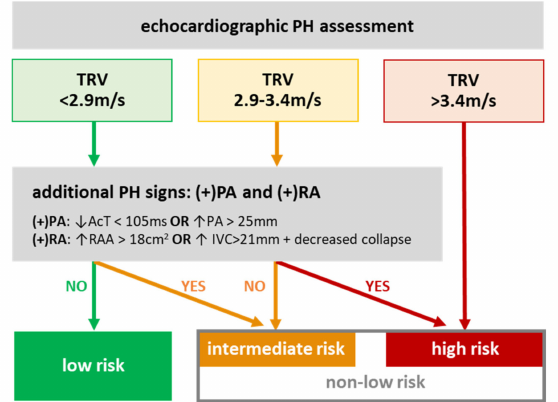
Figure 1. PH-risk assessment with echocardiography. Low PH-risk was defined as TRV < 2.9 m / s (or not measurable), and not more than one additional echocardiography PH sign; intermediate risk was defined as TRV < 2.9 m / s with two additional PH signs, or TRV 2.9–3.4 m / s and not more than one additional PH sign; high risk was defined as TRV 2.9–3.4 m / s with two additional PH signs, or TRV > 3.4 m / s. The additional signs for echocardiographic PH were defined as the presence of at